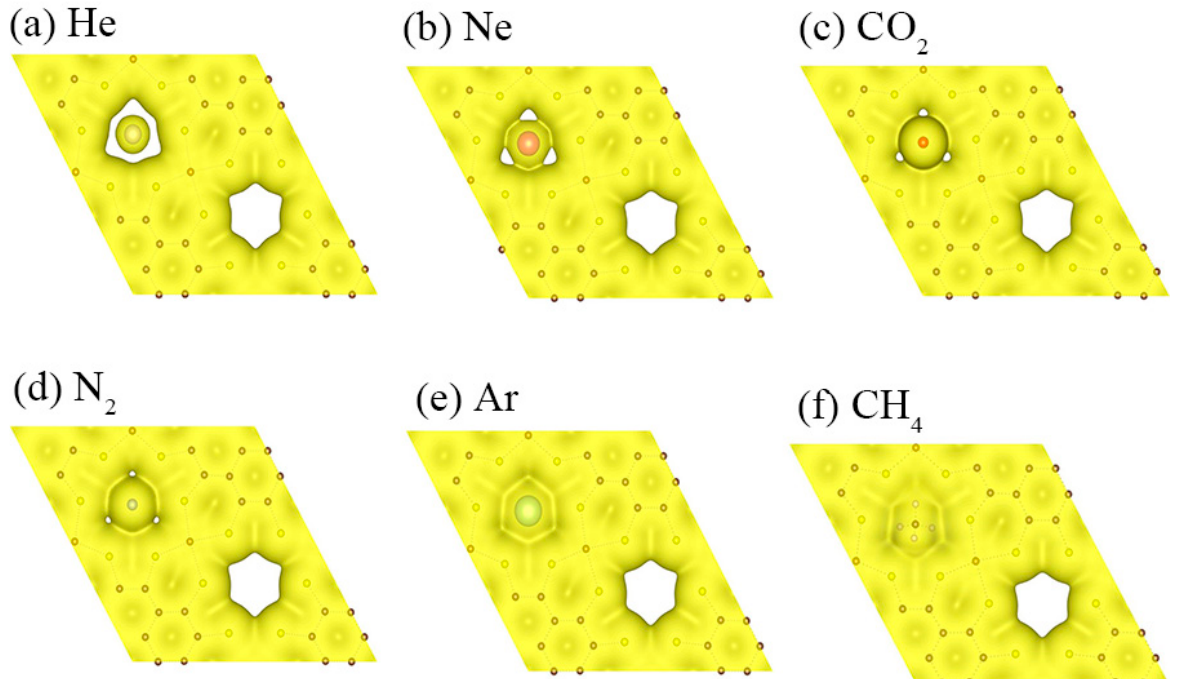
Figure 2. Electron density isosurfaces for the gas molecules: ( a ) He, ( b ) Ne, ( c ) CO 2 , ( d ) N 2 , ( e ) Ar and ( f ) CH 4 translocating the Fe-PTC membrane (isovalue of 0.01 Å − 3 ).